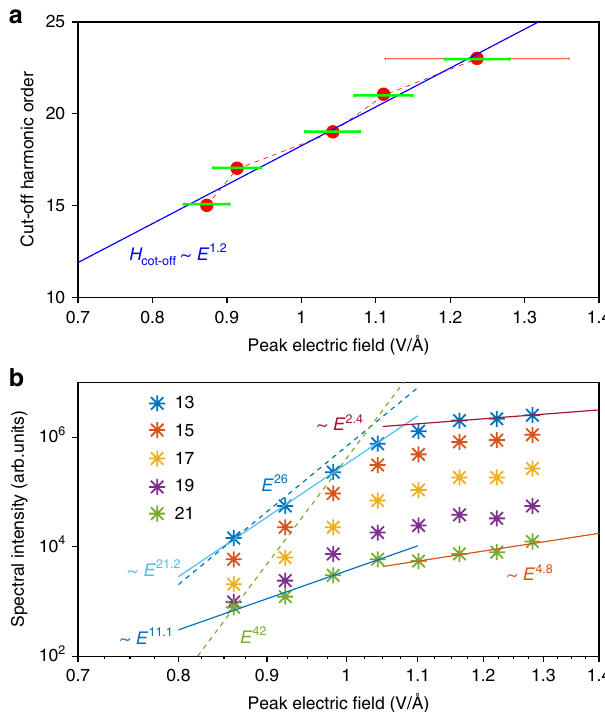
Fig. 2 Non – perturbative high – order – harmonic generation from liquids. a Cut – off photon-energy dependence on peak electric fi eld strength inside the medium (red dots). A typical absolute (total, approximated, propagated value of multiple measurements performed under identical experimental conditions) error bar of the electric fi eld strength is displayed as a horizontal solid red line. Relative error bars are displayed as horizontal solid green lines. A linear fi t of the high harmonic cut-off photon energy (H cut-off ) performed on a double-logarithmic scale is shown as the solid blue curve on a double-linear scale. b Dependence of the emitted intensity of individual harmonic orders on the peak – electric – fi eld strength. A linear fi t to the fi rst four and the last three data points of H13 and H21 are shown on a double- logarithmic scale. Dashed lines represent the scaling law expected for a perturbative response. Liquid ethanol was used as a sample for all data shown here